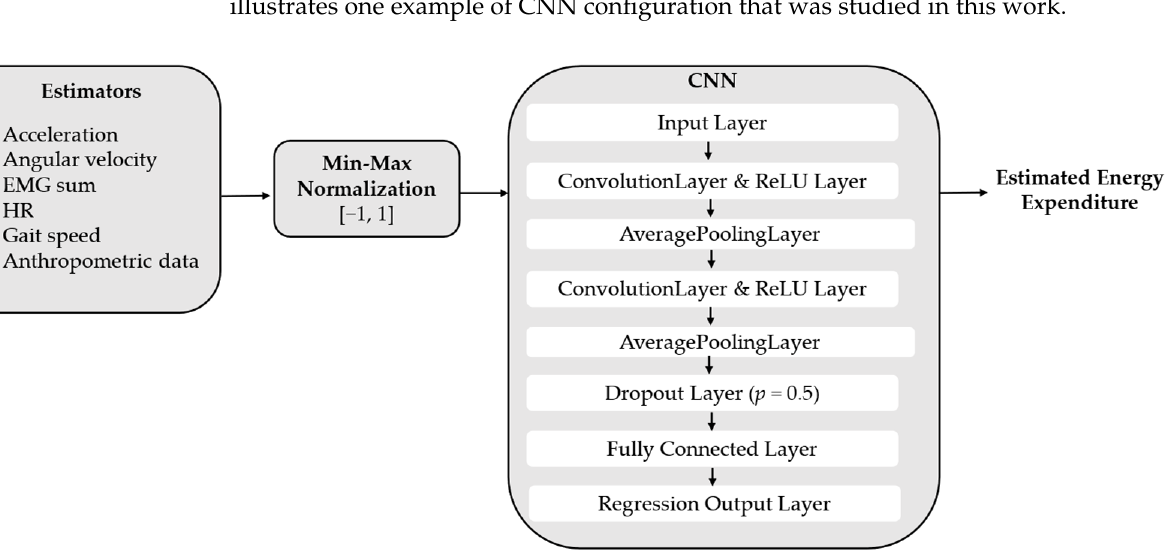
Figure 3. LSTM’s architecture of the final model.